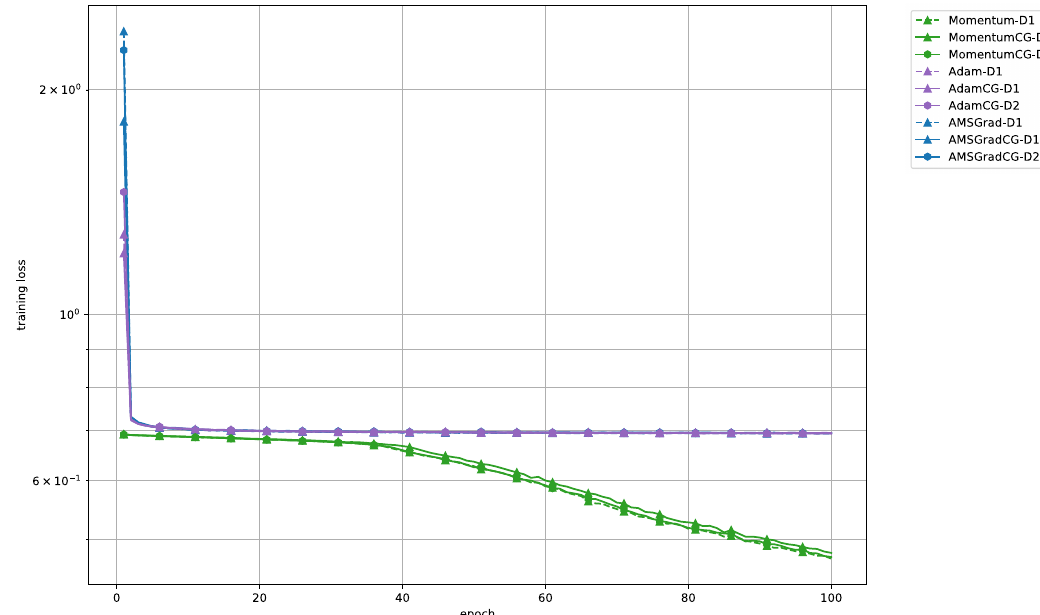
Figure 10. Loss function value versus number of epochs on the IMDb dataset for training